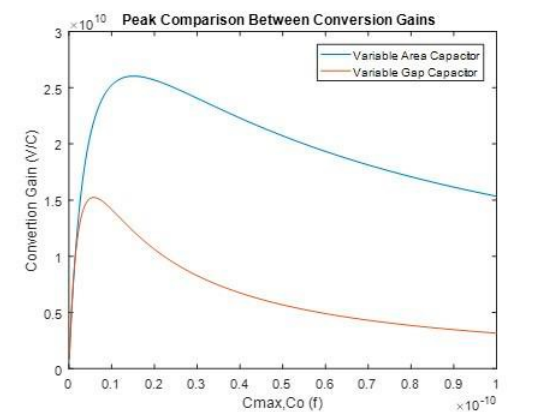
Figure 2. Peak comparison between the maximum charge conversion gains of the variable area and gap capacitor electrometers. The plots were created from Equations (7) and